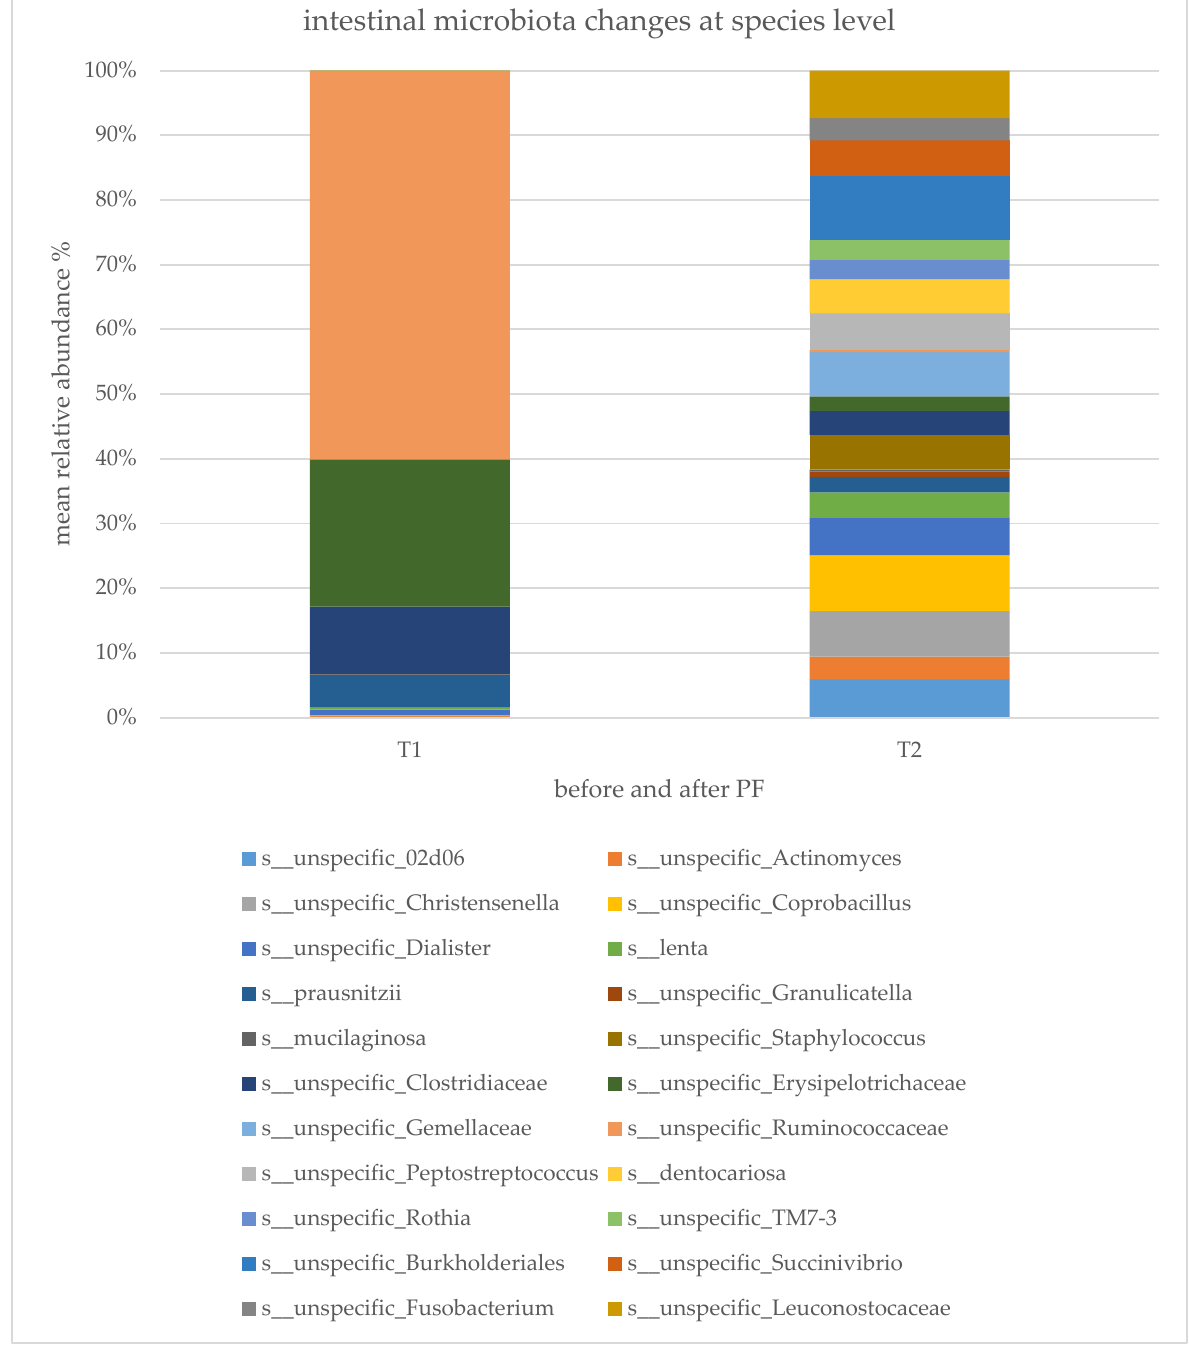
Figure 5. Microbial changes at species level before and after PF. Bar charts of all statistically significant changes of the sequencing data at species level given in mean relative bacteria abundance in % for the fasting group. Statistical significance was determined using paired t -test for parametric values and Wilcoxon test for nonparametric values and defined as p < 0.05.